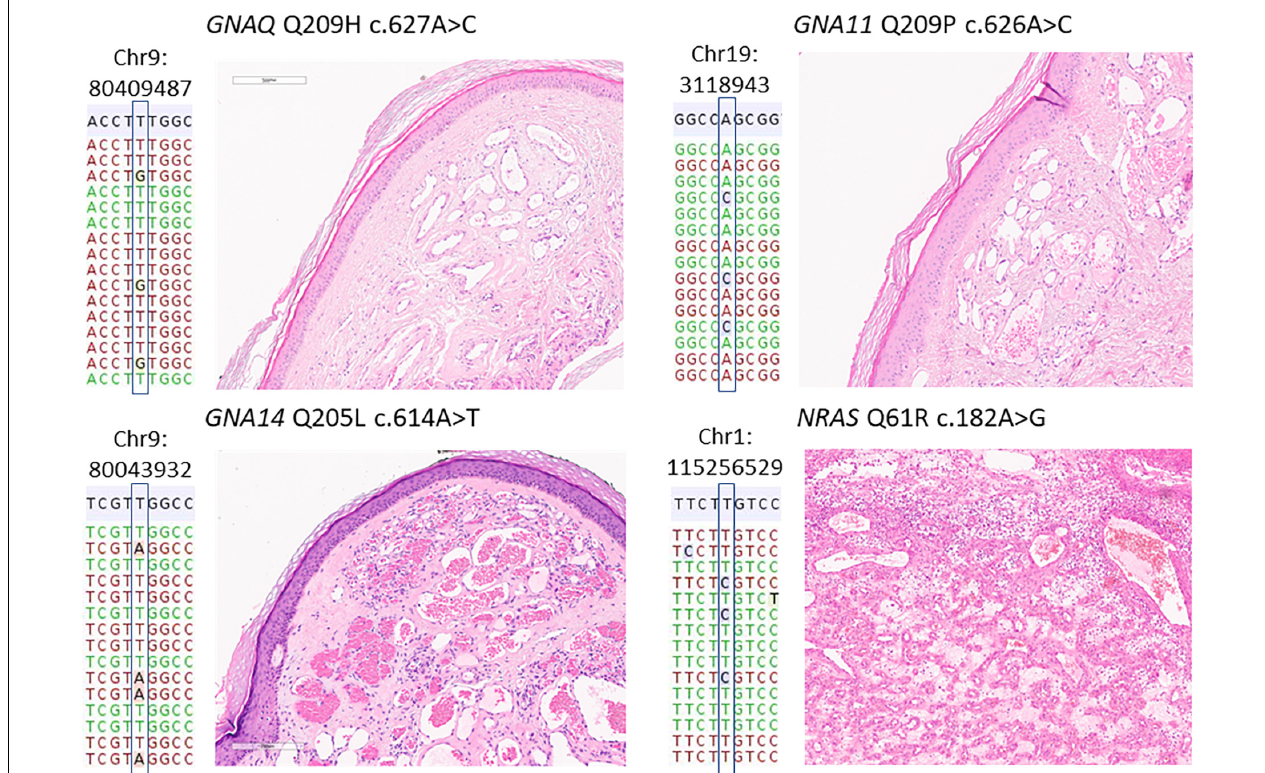
FIGURE 2 | Representative mutations and histology in benign vascular proliferations. Representative histological images and the respective mutations identified in four vascular tumors. The mutations are annotated according the human genome build 19 (hg19). The reference hg19 sequence is shown in gray, below a representative selection of reads, some of which harboring the mutated nucleotide. All vascular tumors shown here were diagnosed as lobular hemangioma, the NRAS mutant case (bottom right) as the subtype eruptive hemangioma. TABLE 3 | Associations of mutations with histological subtypes of hemangiomas and vascular malformations. All WT GNA14 mutant GNA11 mutant GNAQ mutant NRAS mutant P -value* n =